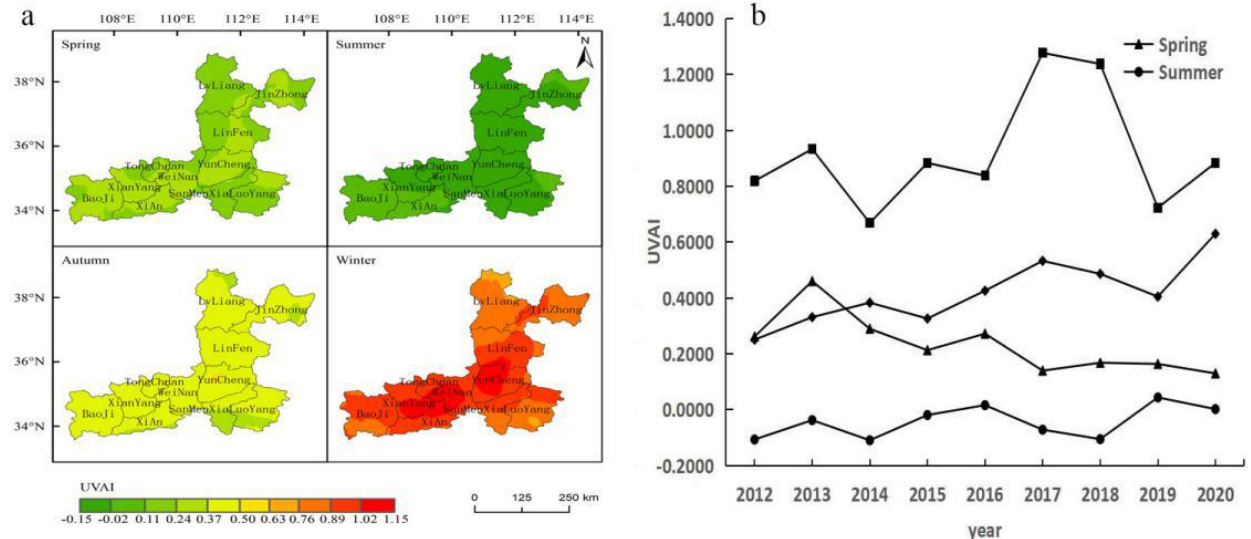
Figure 5. Seasonal changes of UVAI in the Fenwei Plain from 2012 to 2020: ( a ) the four-season spatial distribution of UVAI values and ( b ) the four-season temporal change of UVAI values.